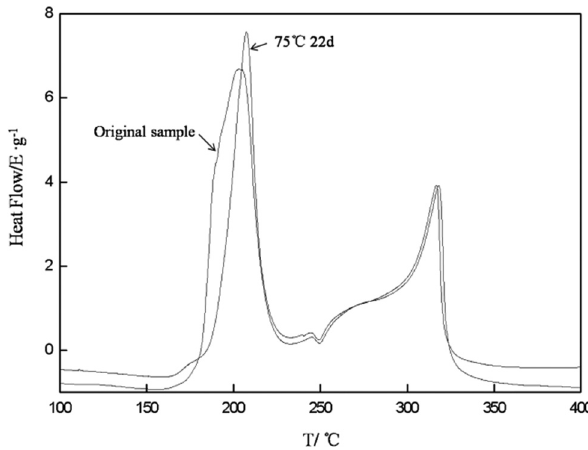
Figure 4: DSC curves of GaTo before and after aging at 75°C for 22 days at the heating rate of 10°C · min − 1